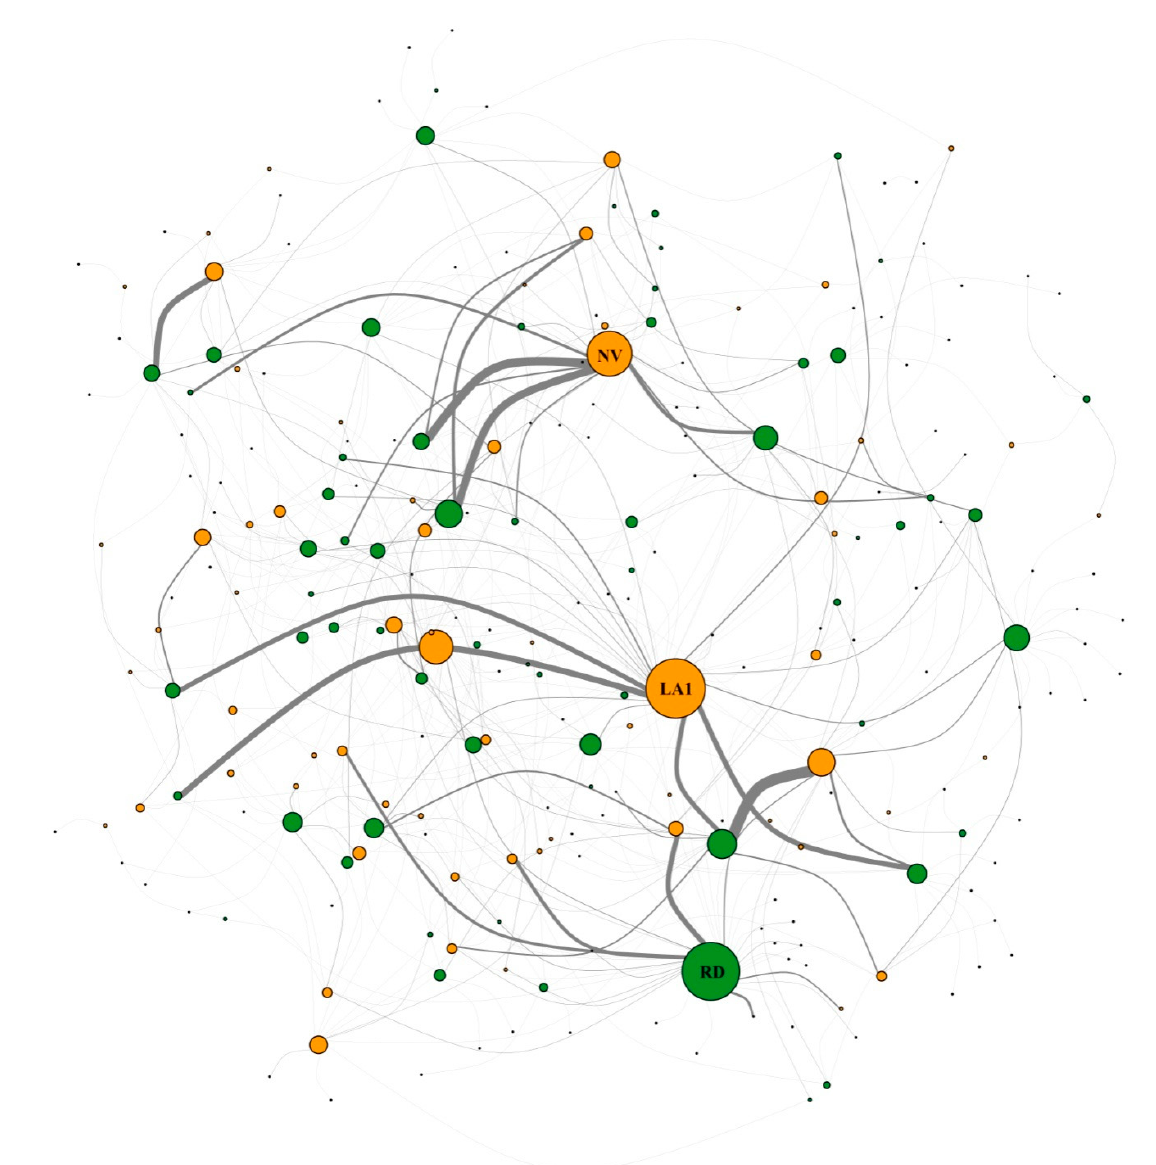
Figure 2. The total network combining all interaction data from all sites. Green cycles representing plant species, orange cycles representing beetle species. The largest circles are labeled RD = Rhododendron decorum Franch. (RD), LA1 = Lamiogethes sp.1 (LA1) and NV = Nonarthra variabilis Baly